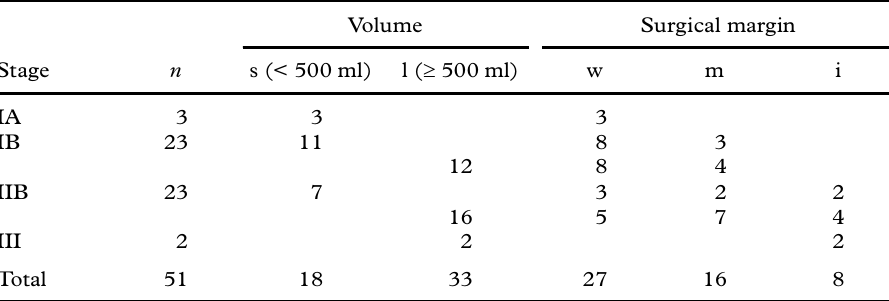
Table 3. Stage, tumor volume and achieved surgical